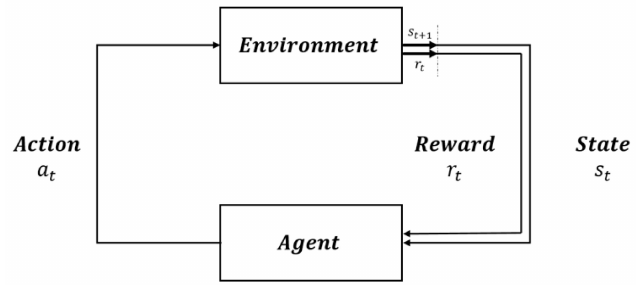
Figure 10. Reinforcement Learning